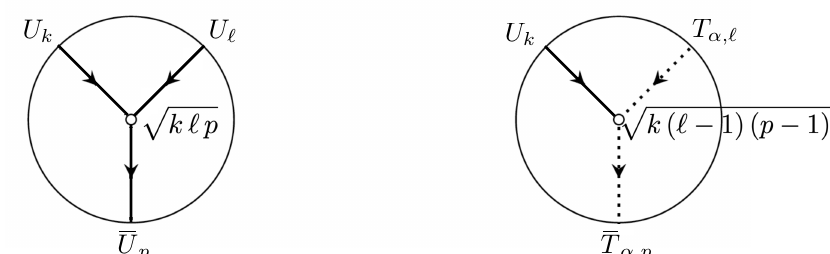
and $ we have chosen, is k α,k